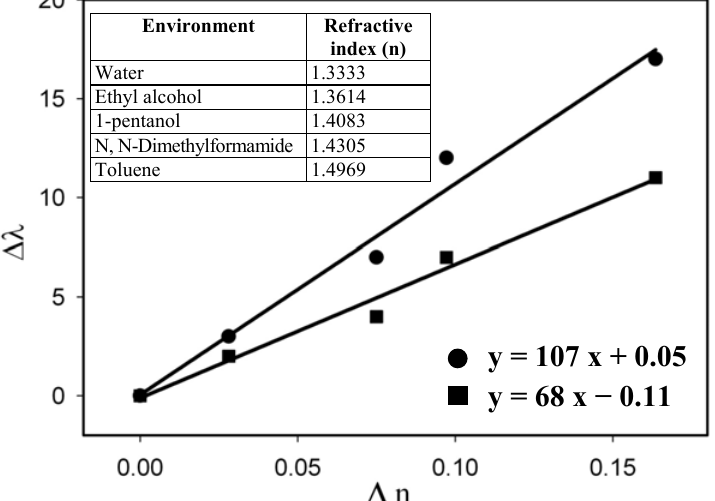
Figure 9. Refractive index sensitivity of the MW-irradiated non-annealed ( ) and annealed ( ) samples.